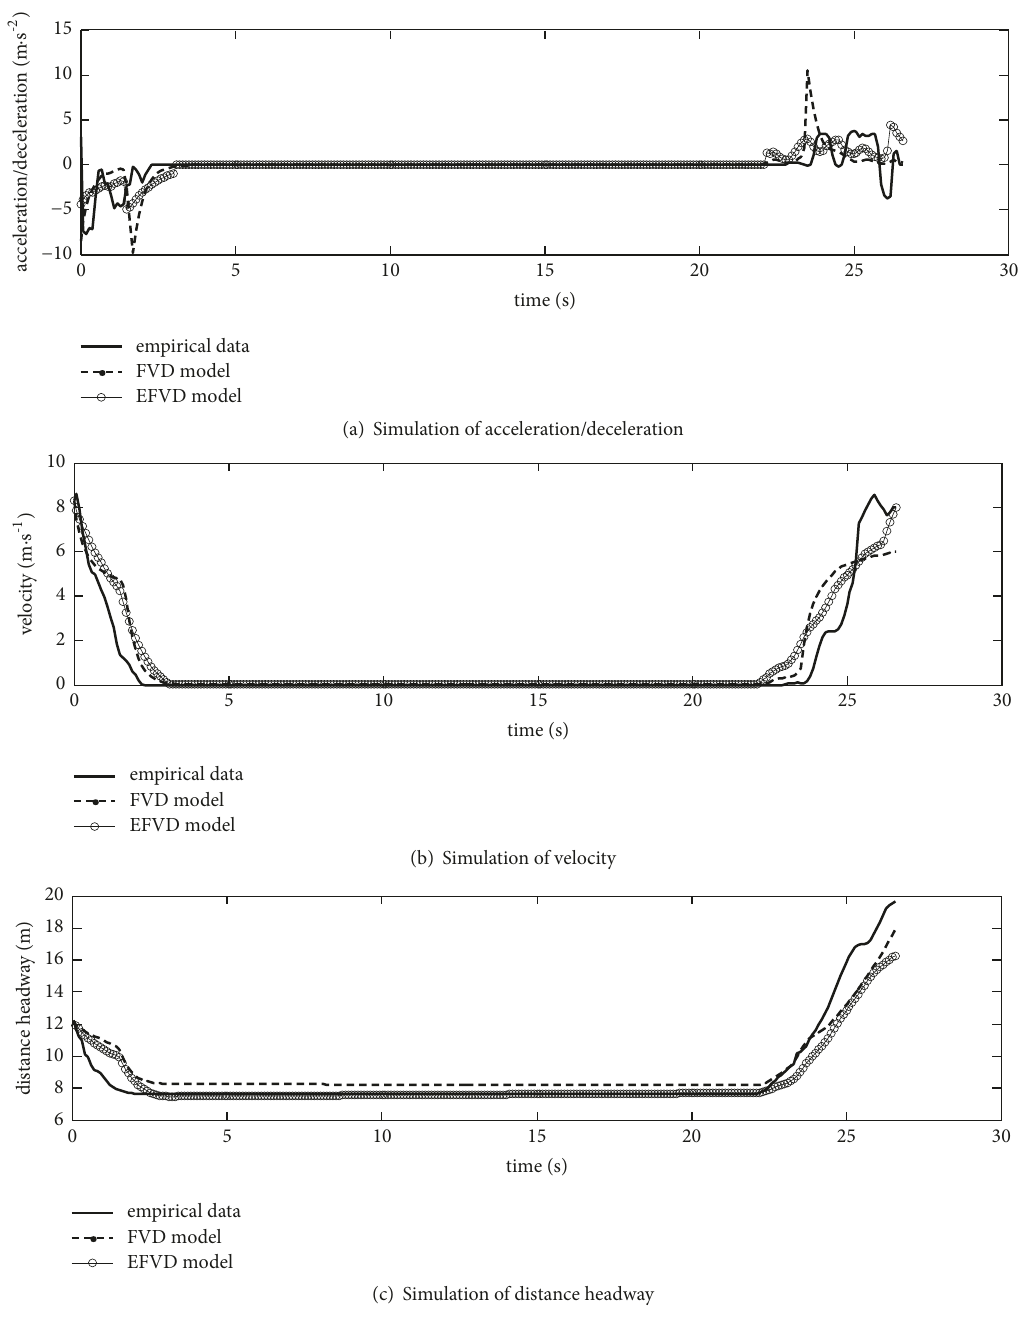
Figure 12: Simulation comparison of car-following Process